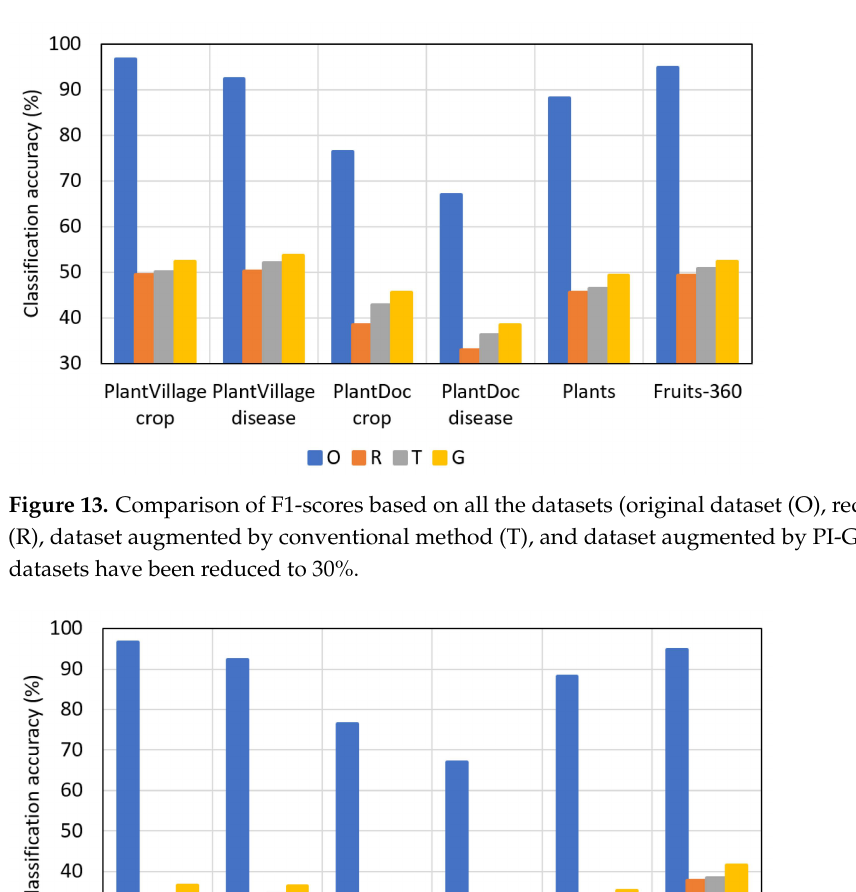
Figure 12. Comparison of F1-scores based on all the datasets (original dataset (O), reduced dataset (R), dataset augmented by conventional method (T), and dataset augmented by PI-GAN (G)). The datasets have been reduced to 50%.